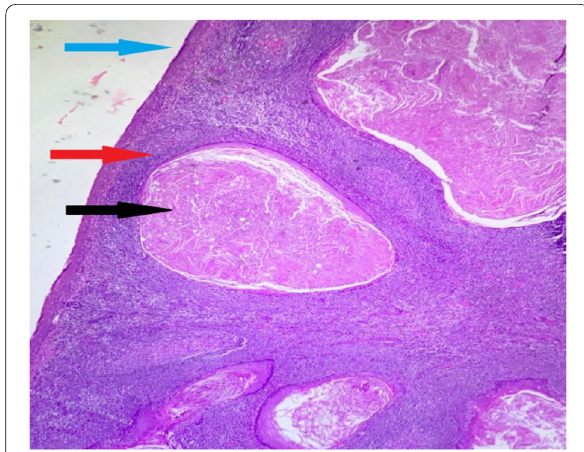
Fig. 6 Tonsillar epidermoid cyst on HPE. Black arrow—dilated cysts filled with keratinized debris, inflammatory cells. Red arrow— cyst lined by keratinized stratified squamous epithelium. Blue arrow—palatine tonsil lined by non-keratinized stratified squamous